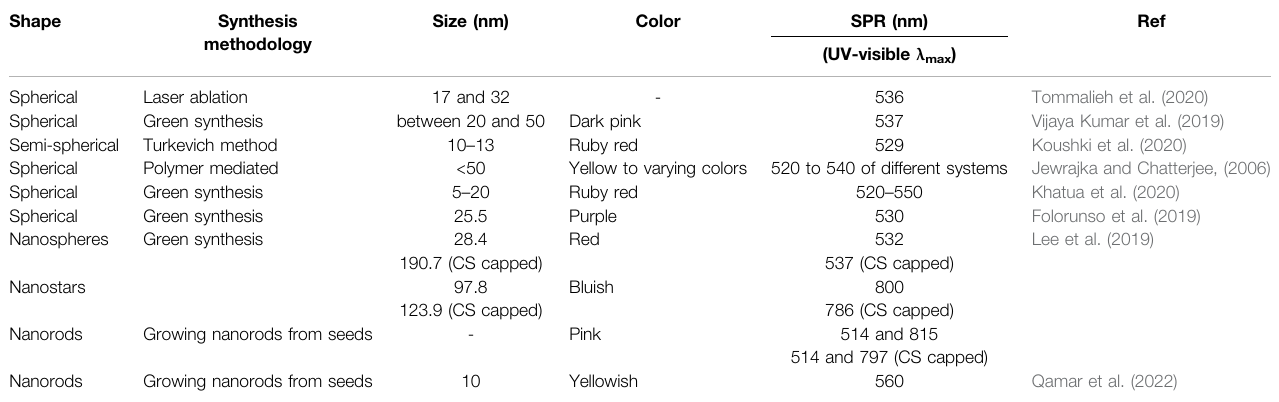
TABLE 1 | The characteristic optical properties of